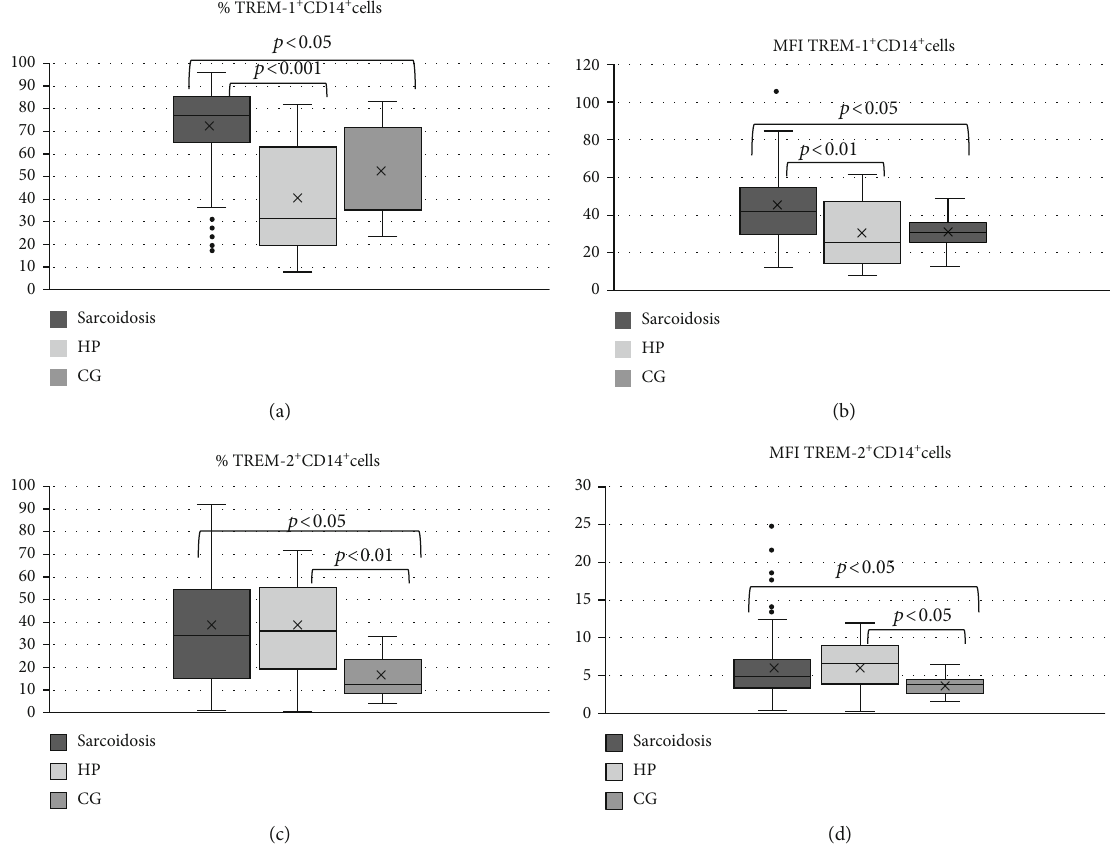
Figure 1: Comparison of TREM-1 and TREM-2 expression. (a) Percentage of TREM-1 + CD14 + cells, (b) TREM-1 MFI, (c) percentage of TREM-2 + CD14 + cells, (d) TREM-2 MFI. HP: hypersensitivity pneumonitis; CG: control